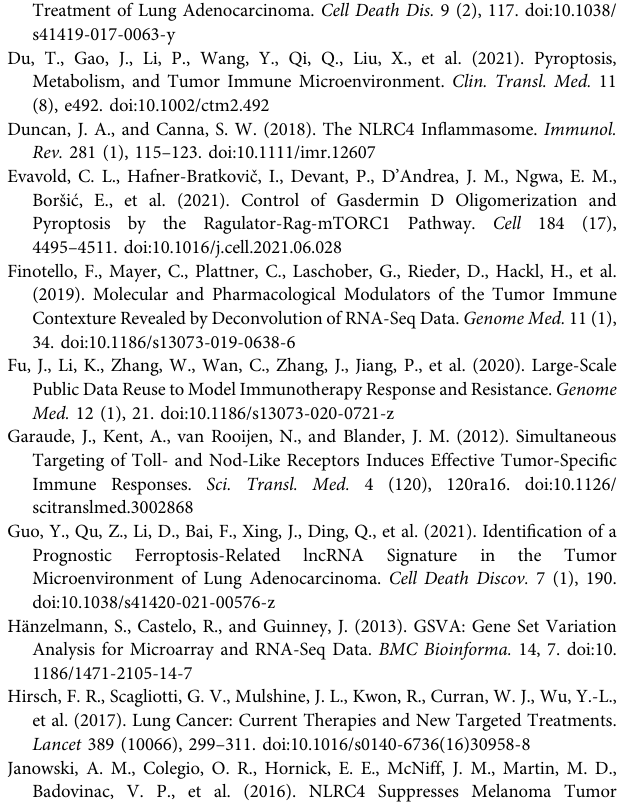
Supplementary Figure S1 | Expression and prognosis analysis of NLRC4 and SCAF11/SIP1. (A) KM curves of NLRC4 and SCAF11/SIP1 in LUAD patients obtained from the KMPlot. Differential expression of NLRC4 and SCAF11 in GEPIA websites (B) and TIMER2.0 (C) . NLRC4 nod-like receptor family CARD domain containing 4, SCAF11/SIP1 SR-related CTD associated factor 11, LUAD lung adenocarcinoma. Supplementary Figure S2 | Differential abundance of in fi ltrating immune cells between high- and low-risk groups in LUAD. TME: tumor microenvironment, LUAD: lung adenocarcinoma. Supplementary Figure S3 | Correlation analysis between risk score, interacted mRNAs, identi fi ed lncRNAs, and TME in fi ltrating immune cells. TME: tumor microenvironment. Supplementary Figure S4 | Correlation between NLRC4 or SCAF11 and TME immune cell in fi ltration in LUAD from TIMER website. NLRC4: nod-like receptor family CARD domain containing 4, SCAF11: SR-related CTD associated factor 11, TME: tumor microenvironment, LUAD lung adenocarcinoma. Supplementary Figure S5 | Prediction of drug